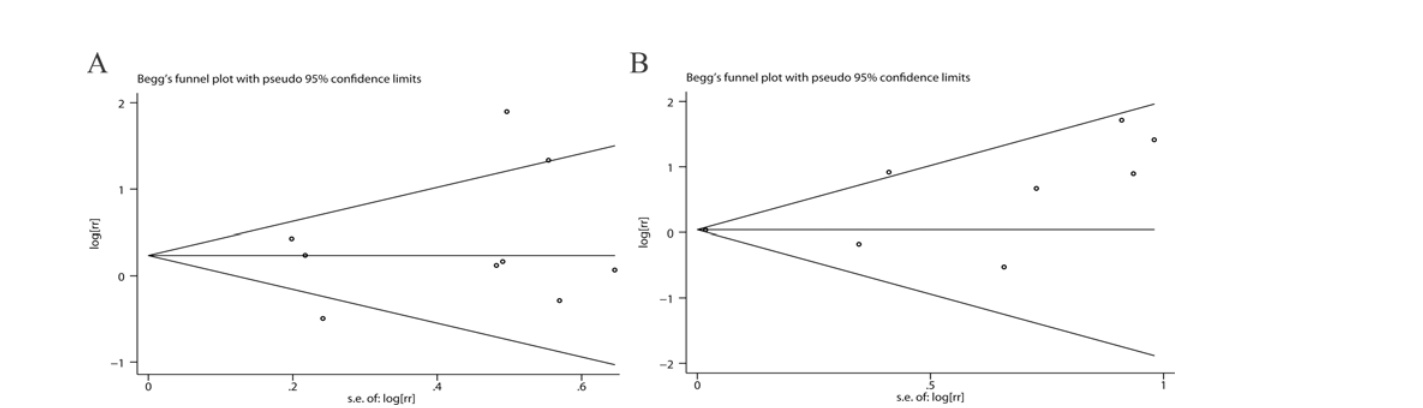
Fig 3. Galbraith plot analysis was used to evaluate heterogeneity. It suggested that two studies were the potential source of heterogeneity for RFS (A), while one for PFS (B).